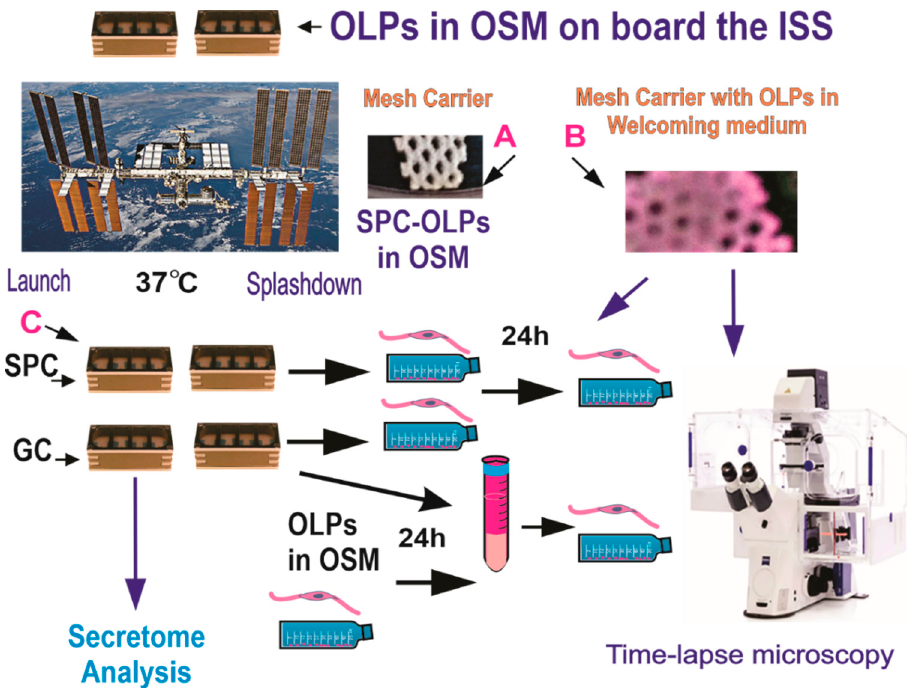
Figure 2. OLPs, as part of the Bioscience-4 Space Biology NASA experiment, flew to the ISS on board SpaceX-21. This experiment was launched on the 6 of December, 2020, and landed (splashed-down) on the 13 of January, 2021. Cells remained in µ G at an orbit height of 254 miles. The experiment is called “passive” because it was designed to mimic the trajectory astronauts’ brains undergo during space flight (i.e., launch, stay in space, and splash down when returning to Earth) without manipulation or medium change. ( A ) Example of mesh without cells. ( B ) View of a mesh carrier populated with cells after space flight. ( C ) View of the hardware units upon return to our laboratory. Ground control cells were seeded and maintained at 37 ◦ C in the same type of hardware and the same conditions in our laboratory, the only difference was the Earth gravity vs. space microgravity. Upon splash ‐ down, they were transferred from Kennedy Space Center to World Carrier and brought to our laboratory (UCLA) at 37°C.